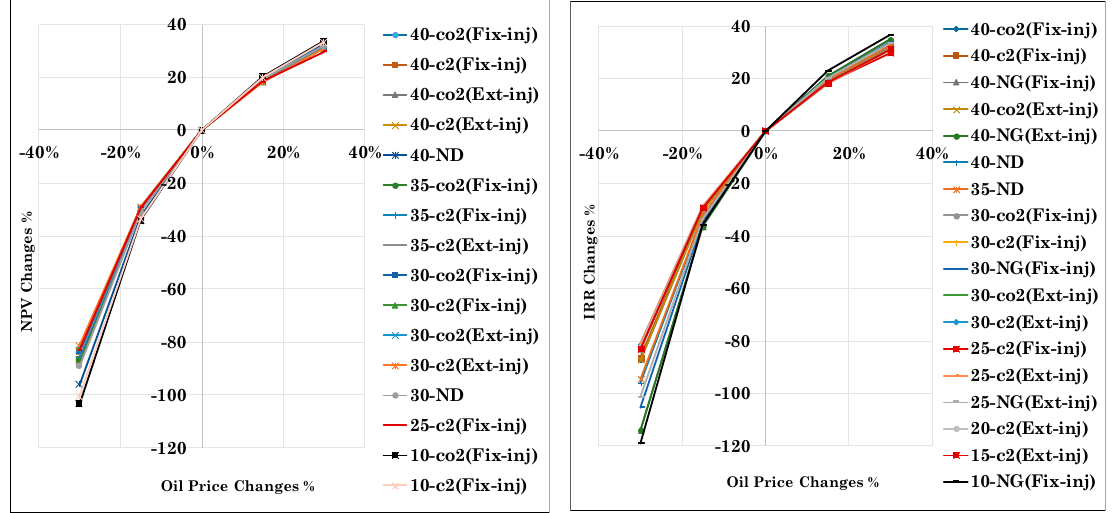
Figure 31. Changes in NPV and IRR coming from variation in Oil Price.